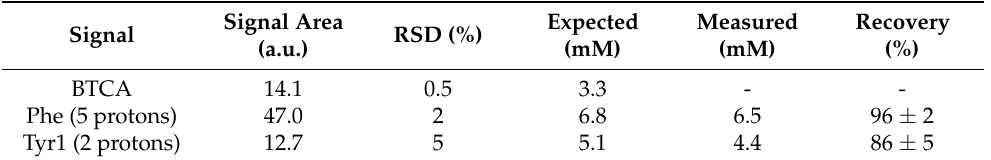
Table 4. Signal areas, concentrations, and resulting recoveries for the hydrolysis and subsequent analysis of BSA hydrolysate; Concentrations of the reference material are certified with an expanded uncertainty of approximately 2 %. Signal